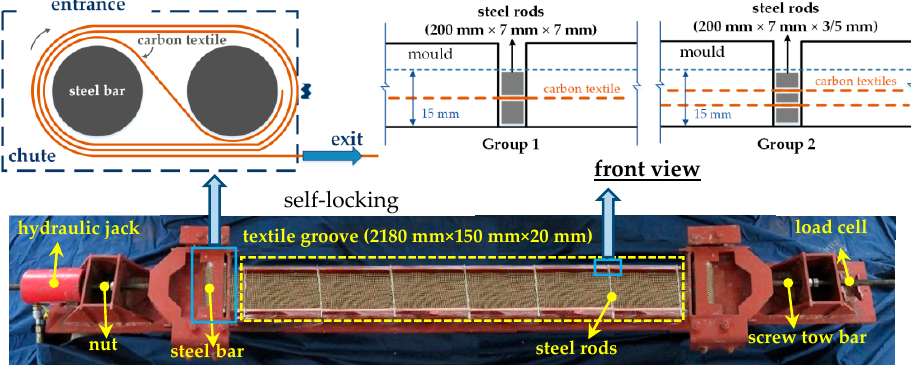
Figure 2. Illustration of the tensioning system.